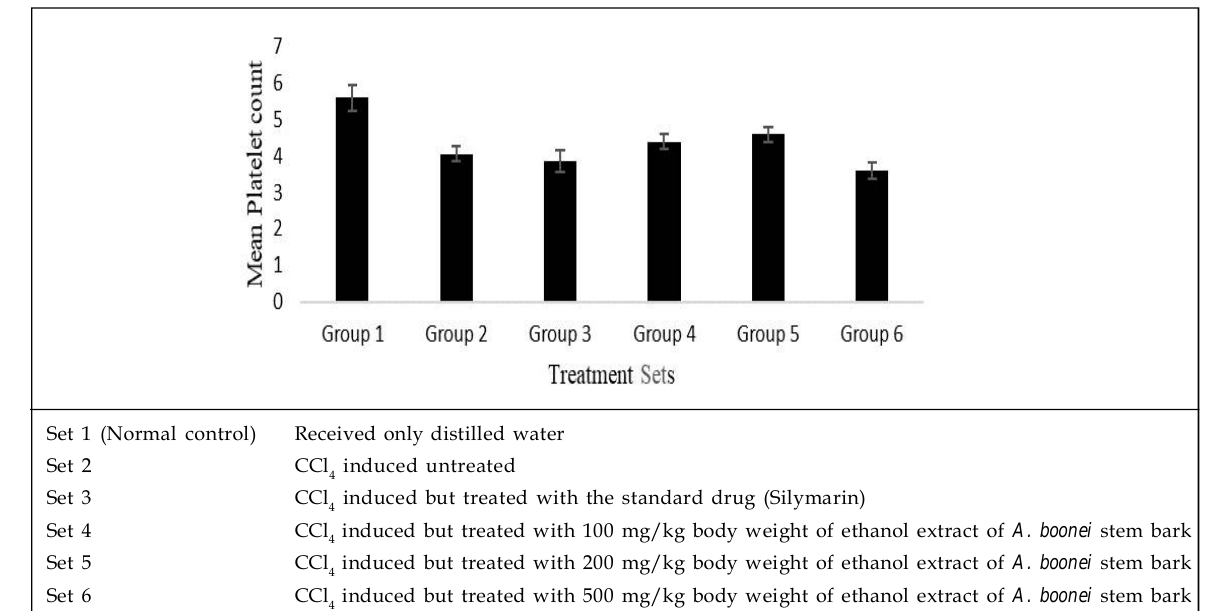
Figure 9: Platelet counts of male Wistar albino rats administered with A. boonei stem bark extract